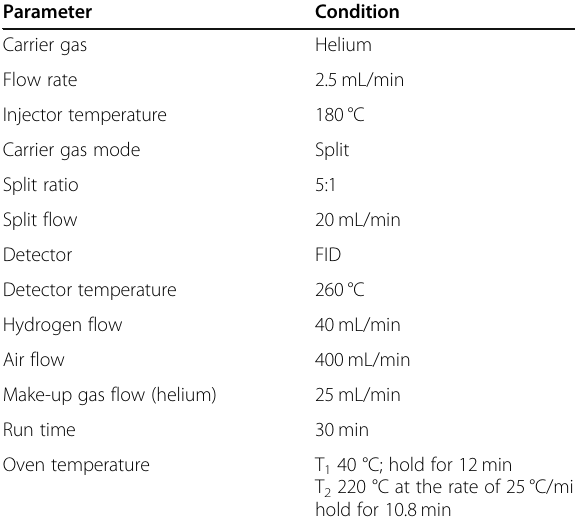
Table 2 Optimized gas chromatographic